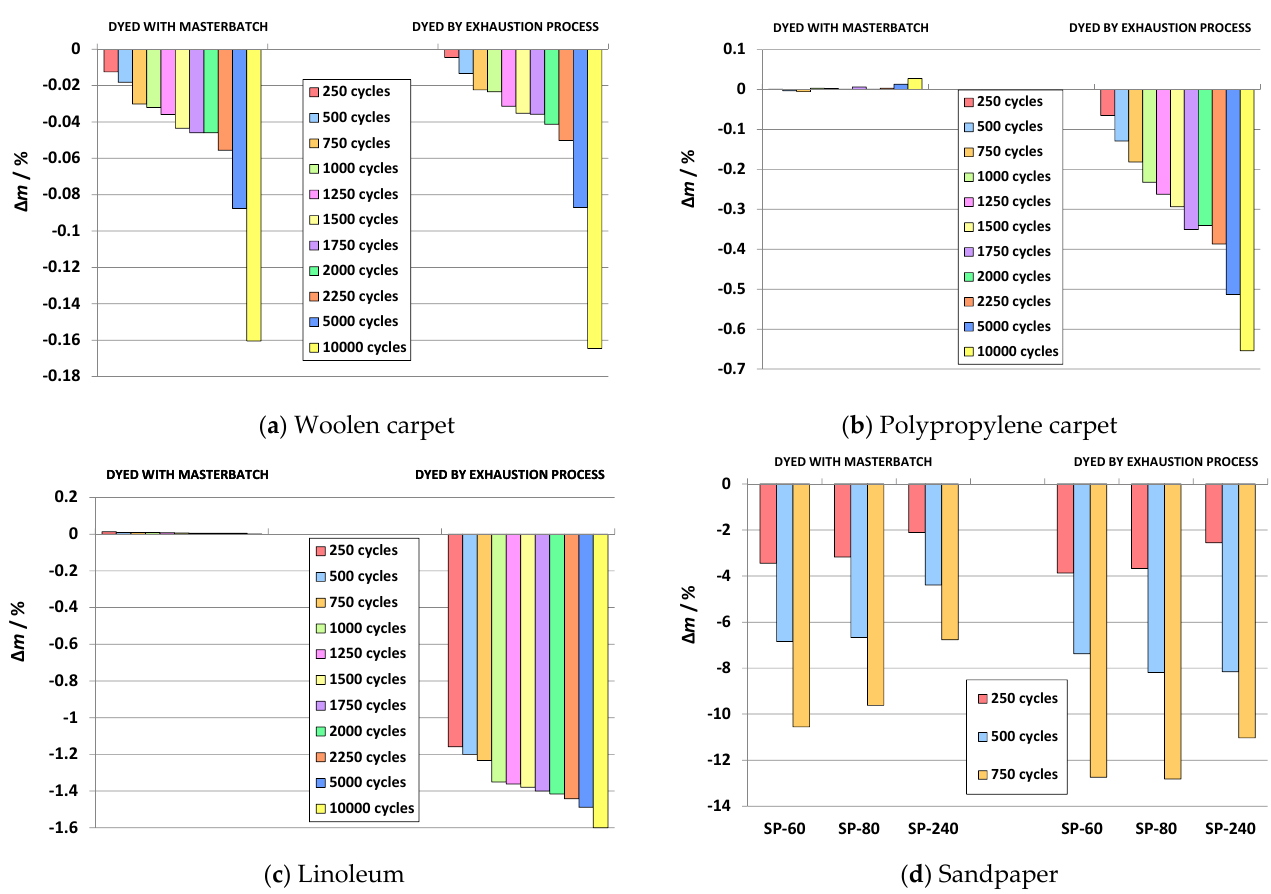
Figure 7. Weight loss of specimens on various abrasives.